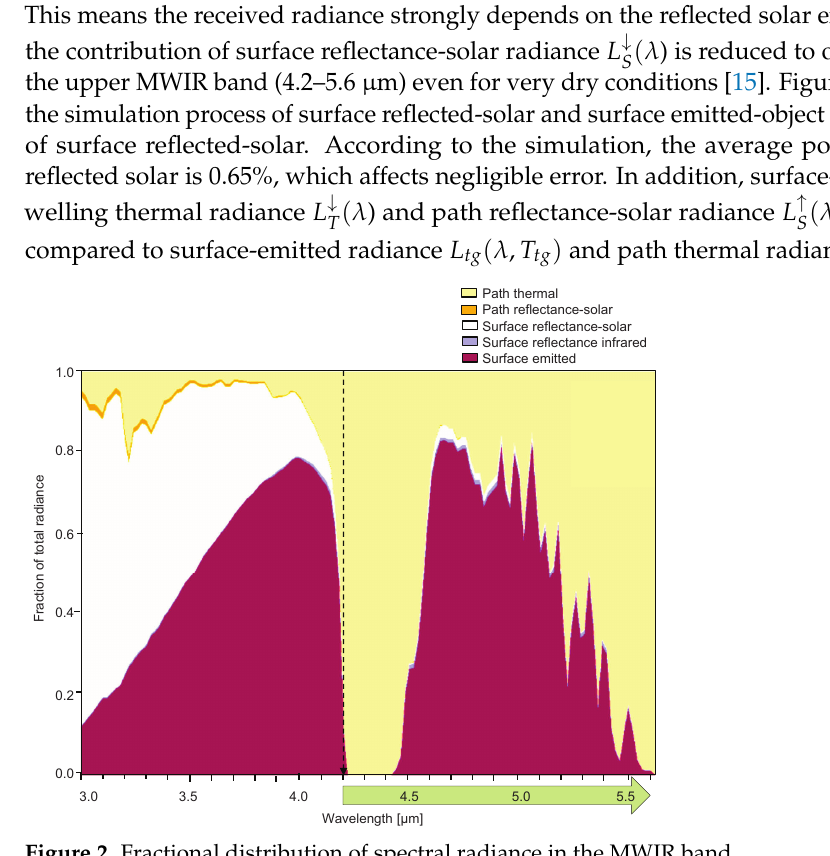
Figure 2. Fractional distribution of spectral radiance in the MWIR